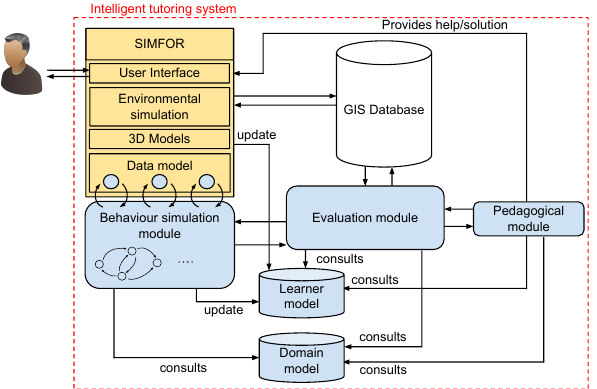
Figure 2. General architecture of the